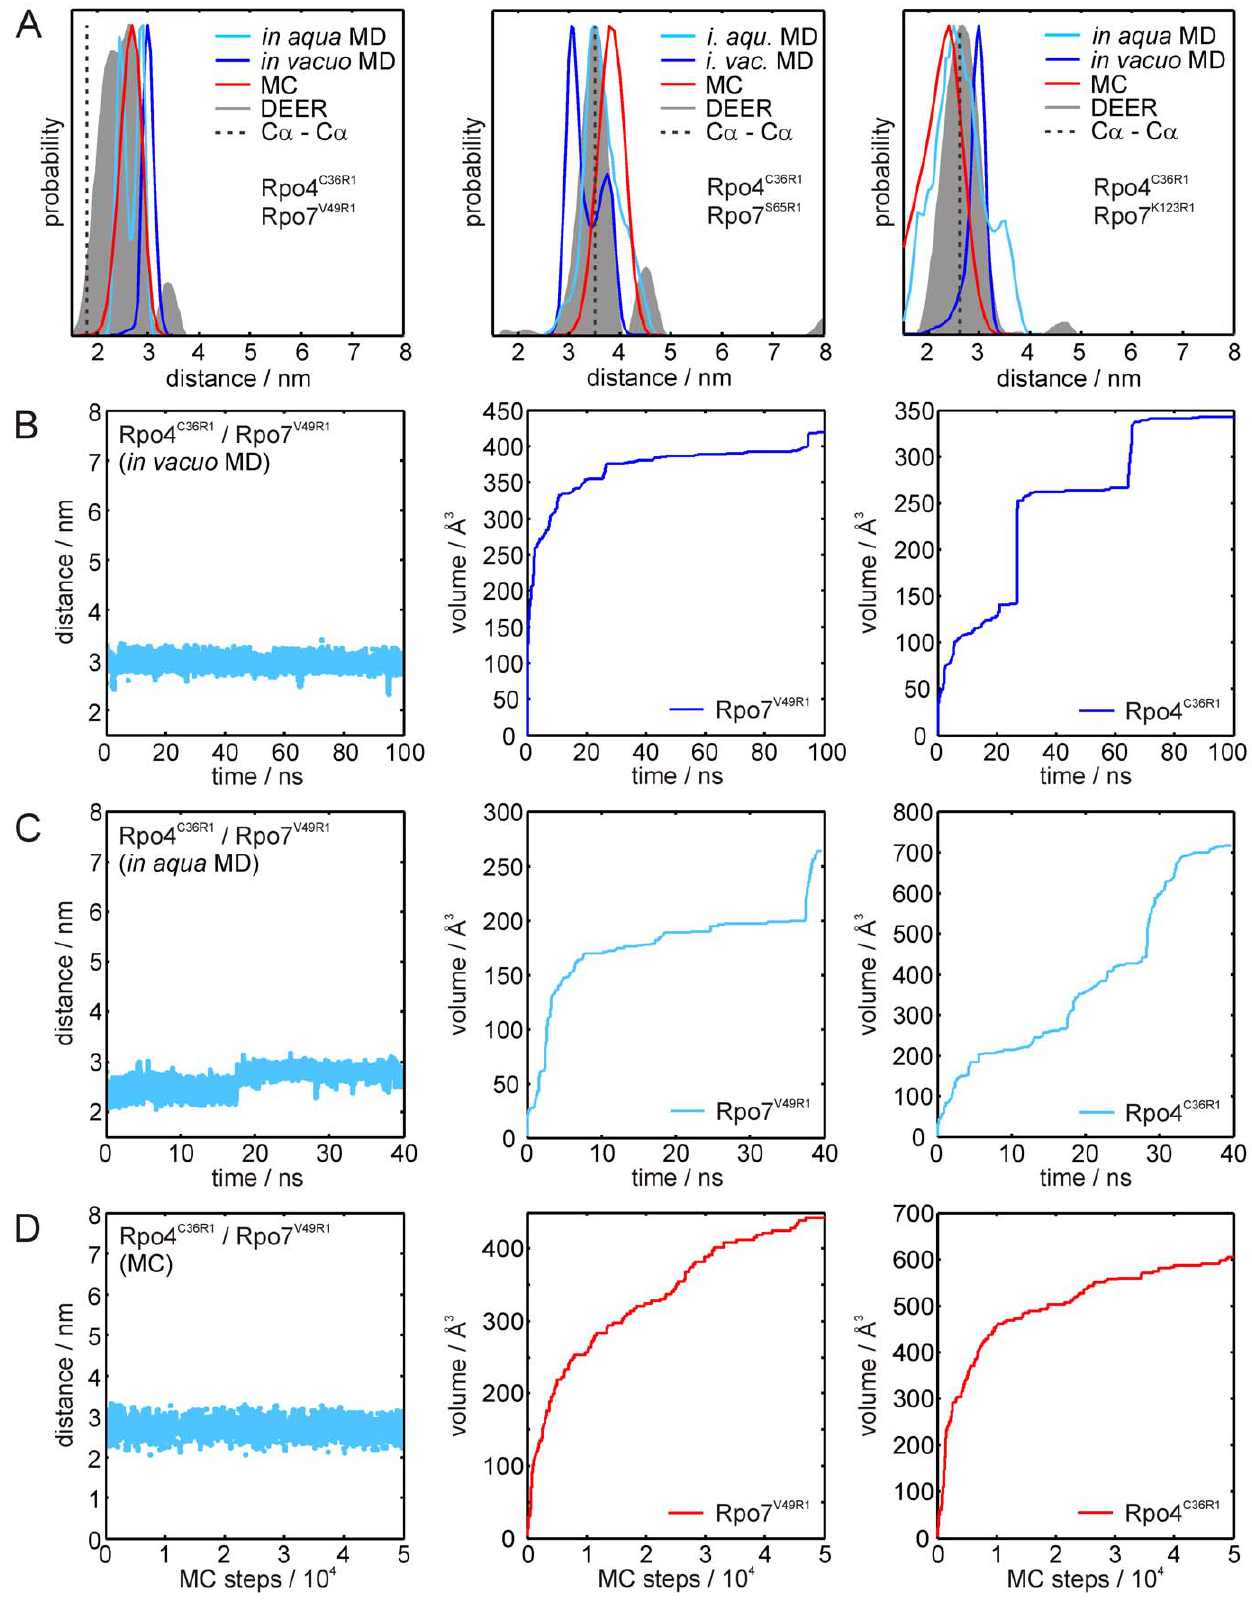
Figure 6. Results of the simulations for spin label pairs Rpo4 C36R1 /Rpo7 xR1 . (A) Distance distributions for the spin label pairs Rpo4 C36R1 / Rpo7 V49R1 (left), Rpo4 C36R1 /Rpo7 S65R1 (center) and Rpo4 C36R1 /Rpo7 K123R1 (right). Distance distributions obtained from the DEER experiments are